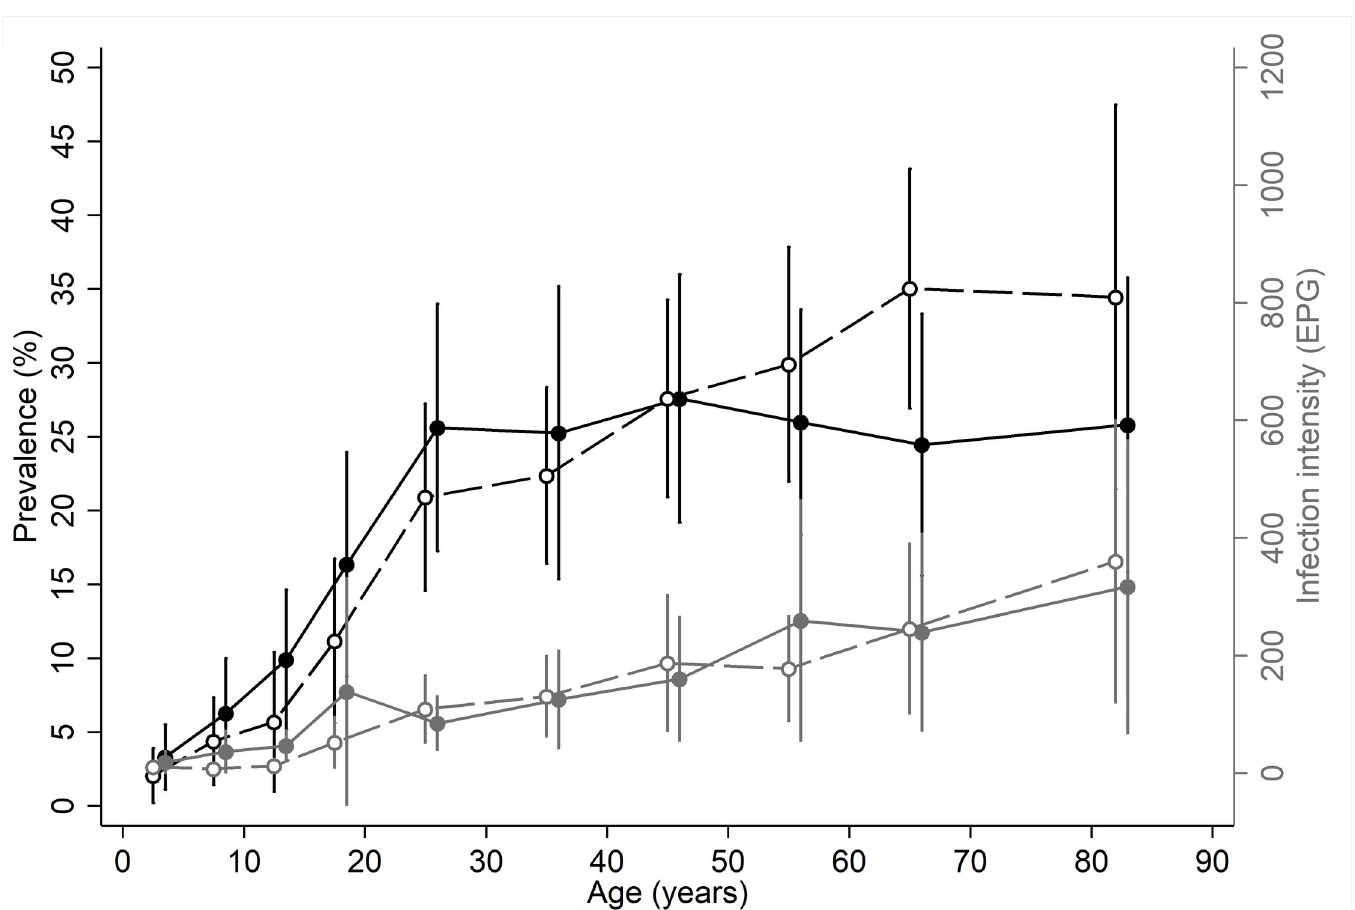
Fig 3. Age-infection profiles of hookworm among surveyed participants at enrolment—prevalence (black lines) and intensity (grey lines) of hookworm infection for males (solid line and circles) and females (dashed lines and empty circles).